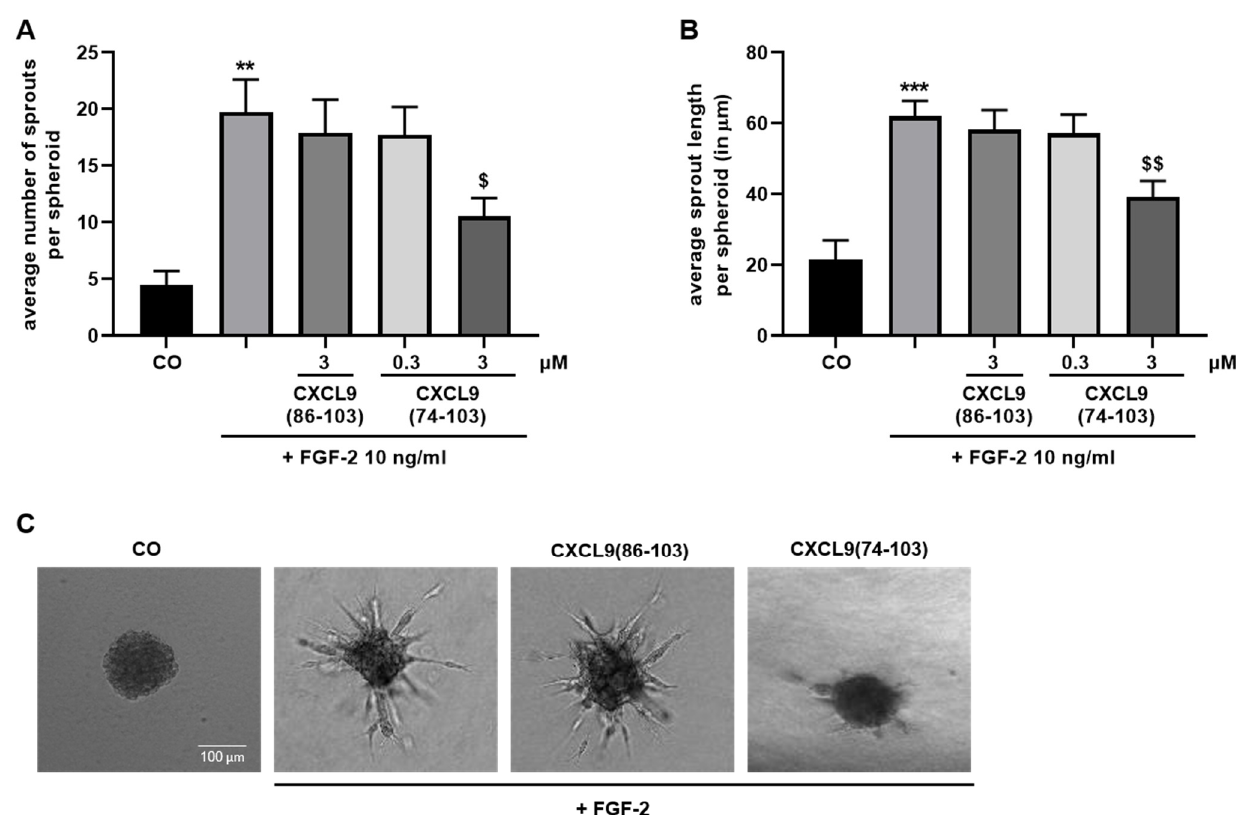
Figure 4. CXCL9(74-103) reduces FGF-2-mediated spheroid sprouting of endothelial cells. Collagen-embedded HMVEC spheroid sprouting in response to 10 ng/mL FGF-2 alone or with CXCL9(86-103) or CXCL9(74-103) at the indicated concentrations was assessed microscopically after 16 hours. The number of sprouts per spheroid was counted and the sprout length was measured using Fiji software. ( A ) Average [mean (±SEM)] number of sprouts per spheroid and ( B ) average sprout length per spheroid (in µm) are depicted. ( C ) Representative images of spheroids that were untreated (CO), stimulated with FGF-2 with or without 3 µM of the indicated CXCL9-derived peptide are shown. Scale bar = 100 µm. [n = 5 experiments, ≥ 3 spheroids per experiment; Mann–Whitney U test; ** p < 0.01, *** p < 0.001 (compared to control); $ p < 0.05, $$ p < 0.01 (compared to FGF-2)].